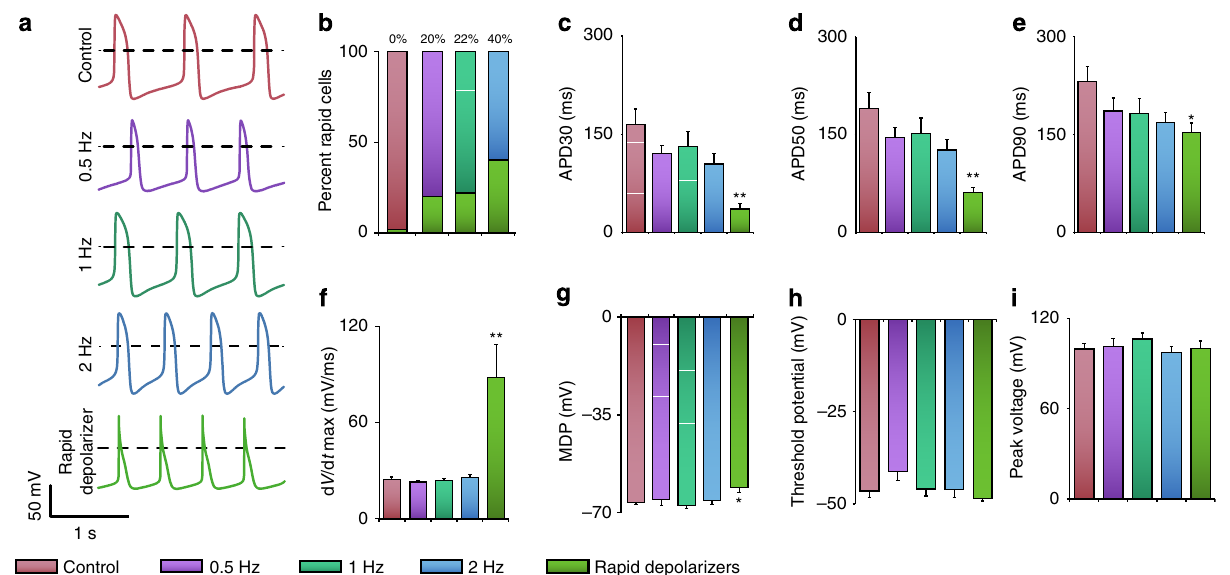
Figure 4 | Electrical conditioning results in a subpopulation of rapidly depolarizing cells. ( a ) Representative action potential traces of the unstimulated, 0.5-, 1- and 2-Hz-stimulated groups. A subset of cells within the stimulated groups displayed unique rapid depolarizing action potentials; the dashed black line represents 0mV. ( b ) The percentage of rapid depolarizing cells increased with increasing stimulation frequency, with no observed rapid depolarizing cells in the control group. ( c – e ) Action potential durations 30, 50 and 90 (APD30, APD50 and APD90) were significantly shorter in the rapid depolarizer group. ( f ) Rapid depolarizers in the 2-Hz group had characteristic high rates of depolarization, with d V d t max (cid:2) 1 approximately three times higher than in ventricular-like cardiomyocytes. ( g ) Maximum diastolic potential was significantly less negative in the 2Hz rapid depolarizer group than any other group. ( h ) Peak voltage and ( i ) threshold potential were similar across all stimulation regimes, as well as in the rapid depolarizing cells. *Significant difference between electrically stimulated groups and the unstimulated baseline, **Significant difference between rapid depolarizing group and control, 0.5Hz, 1Hz, and 2Hz groups. (control: n ¼ 13; 0.5Hz: n ¼ 4; 1Hz: n ¼ 7; 2Hz: n ¼ 9; rapid depolarizer: n ¼ 9; P o 0.05, one-way ANOVA with post hoc Tukey